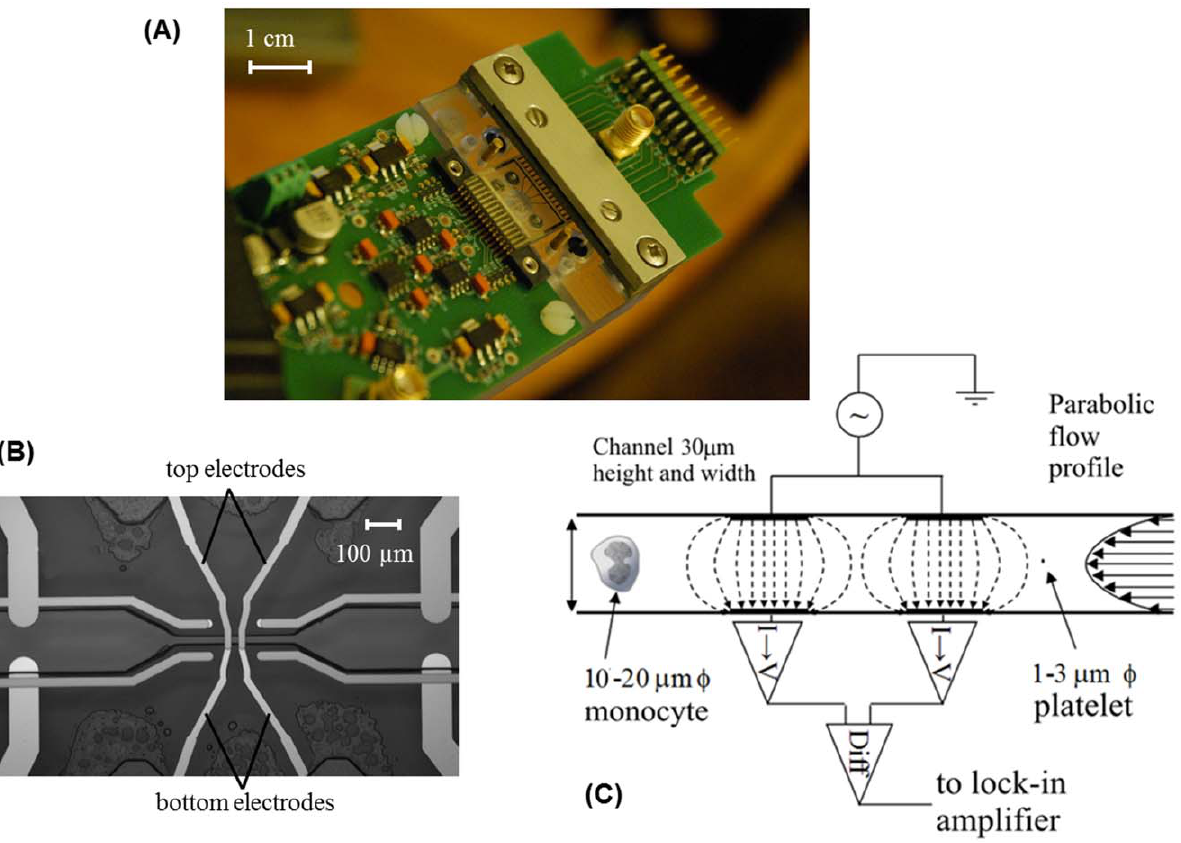
Figure 1. Microfluidic impedance cytometer system. Microfluidic impedance cytometer (A) front-end electronics board mounted with impedance chip (B) close-up (top view) of chip showing two pairs of overlapping electrodes above and below micro-channel (C) schematic diagram (side view) showing detection electronics and cell/platelet inside micro-channel.